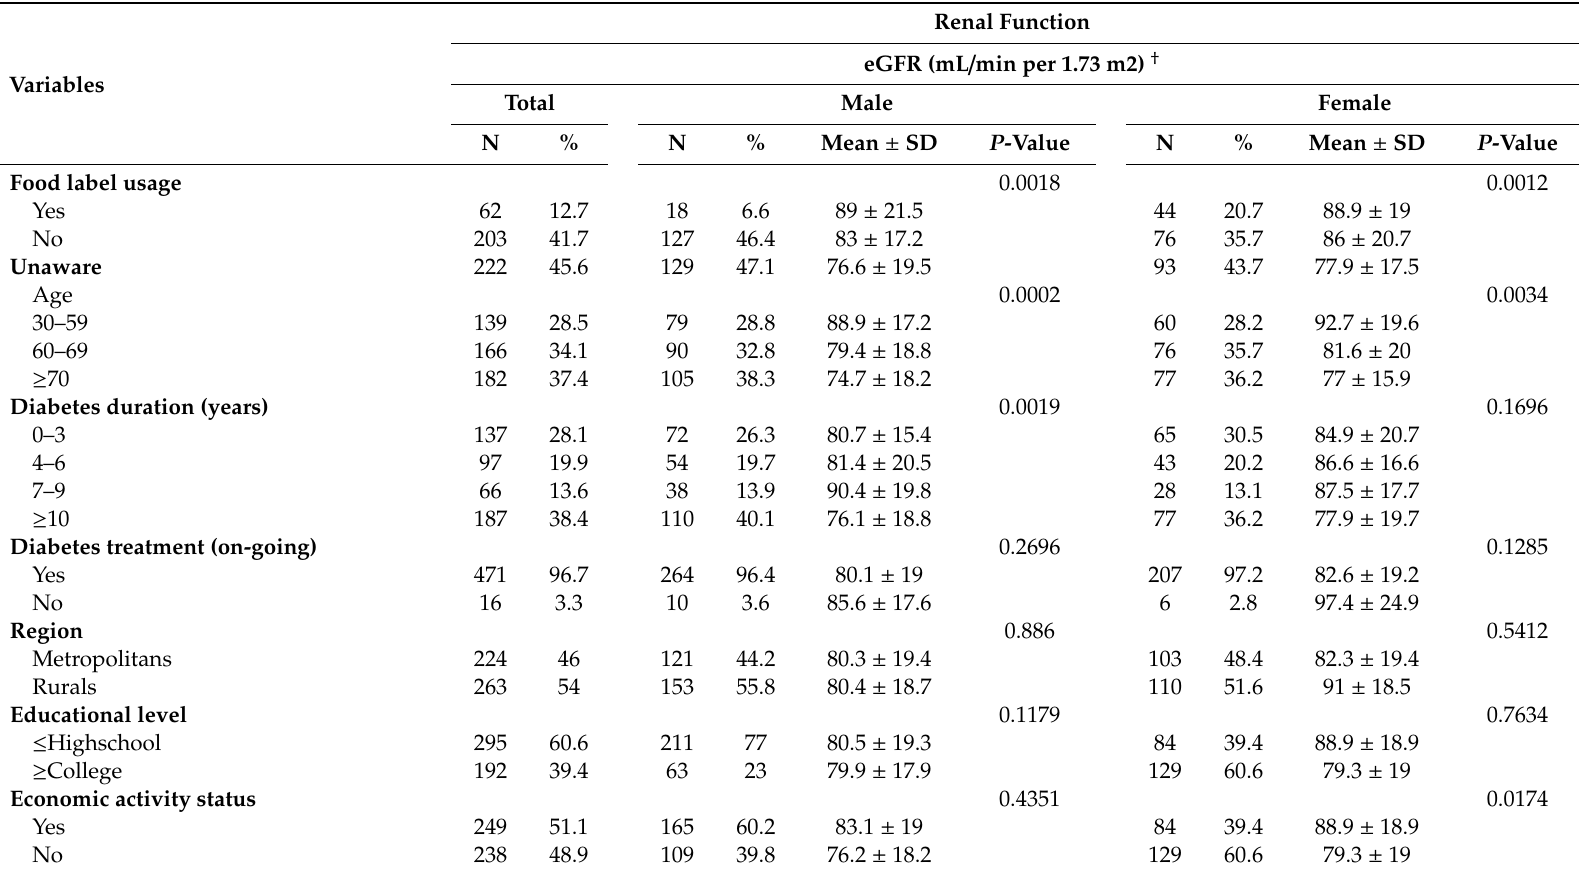
Table 1. General characteristics of the study